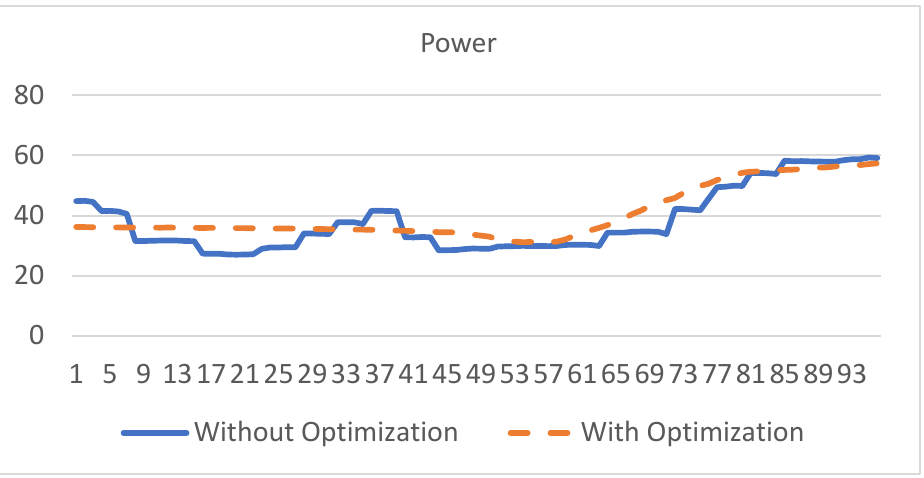
Figure 10. Comparison Results between Current and Optimized Indoor Consumption Power.